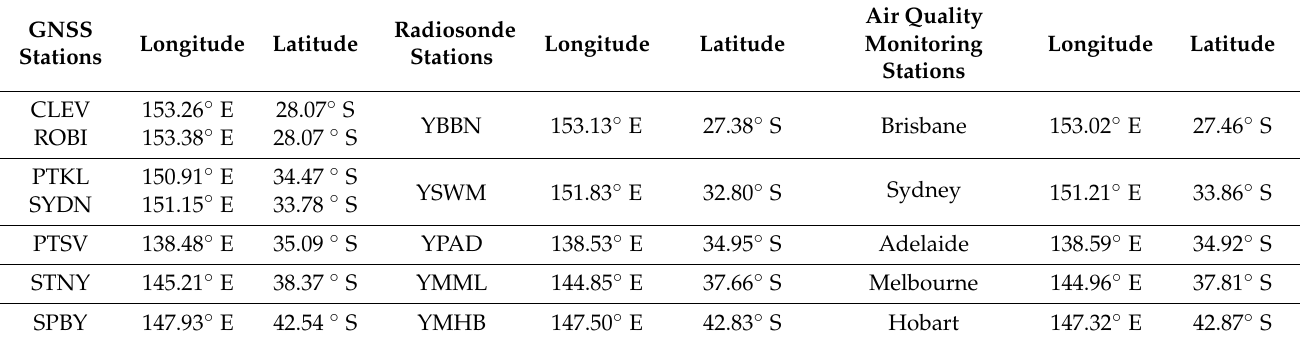
Table 1. Information of GNSS stations, radiosonde stations, and air quality monitoring stations.